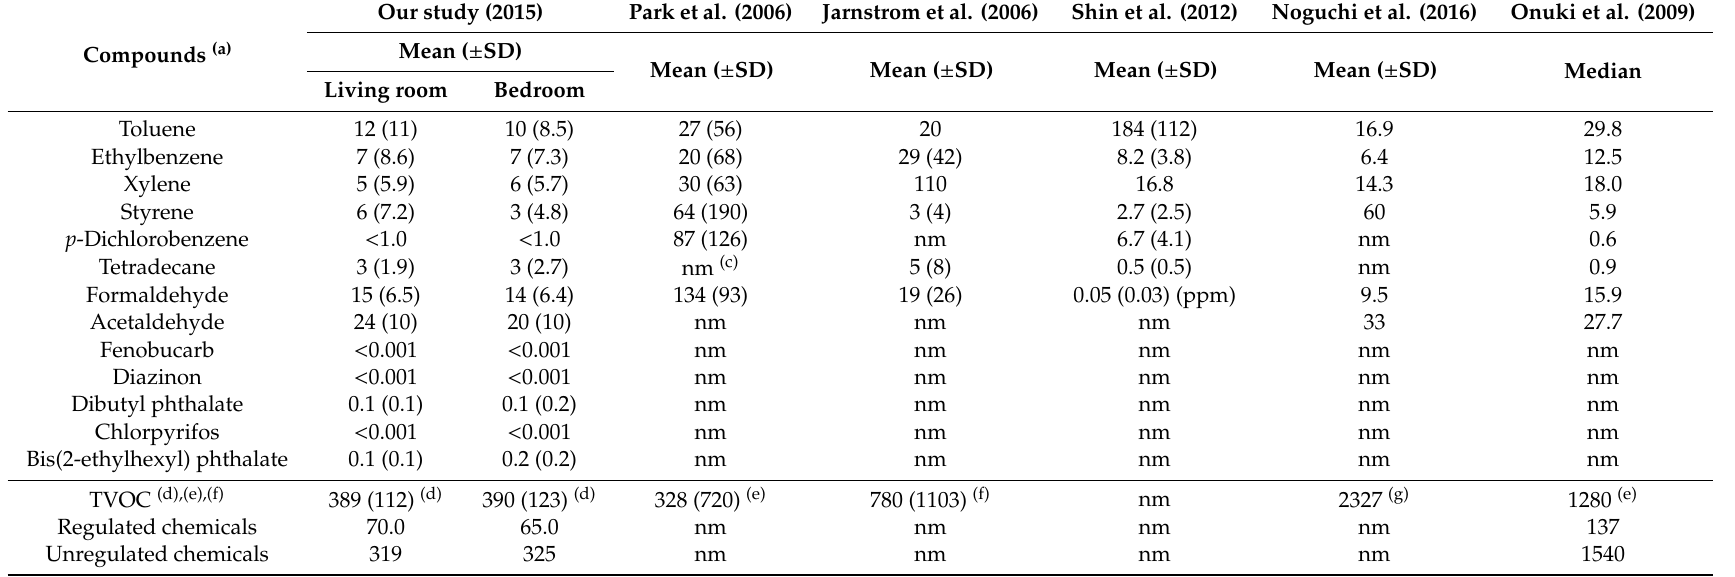
Table 3. Comparison of concentrations of 13 VOCs and TVOC in indoor which have been set by